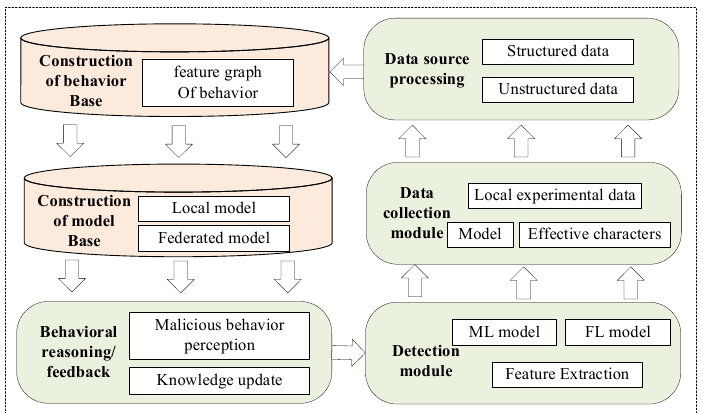
Figure 5. Construction of knowledge base.